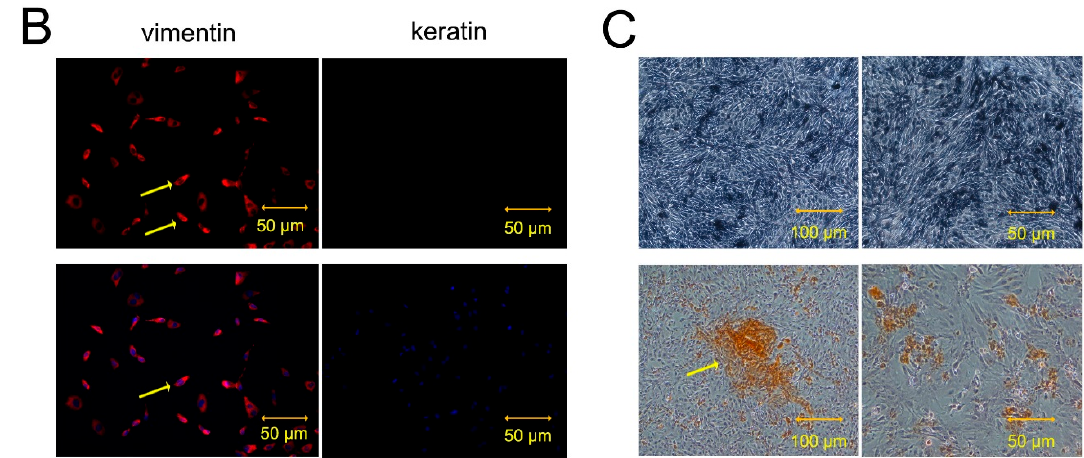
Figure 1. Identification and immunohistochemical staining figures of hAMSCs cells. ( A ) Flow cytometry was used to detect the expression of CD markers. The results showed that hAMSCs cells expressed CD44, CD29, CD90, and CD105 but not CD71, CD19. The red line is the same type of control, and the blue line is the actual expression. ( B ) Immunofluorescence staining display hAMSCs cells expressed vimentin (red) and unexpressed keratin (nucleus staining blue, DAPI). ( C ) An intense staining for ALP was observed after being cultured in osteogenic medium for 2 days. The staining for ALP became much more intense after being cultured in osteogenic medium for 5 days. Obvious calcium deposition (red) and mineralizing nodules (arrows) are visible by alizarin red staining.